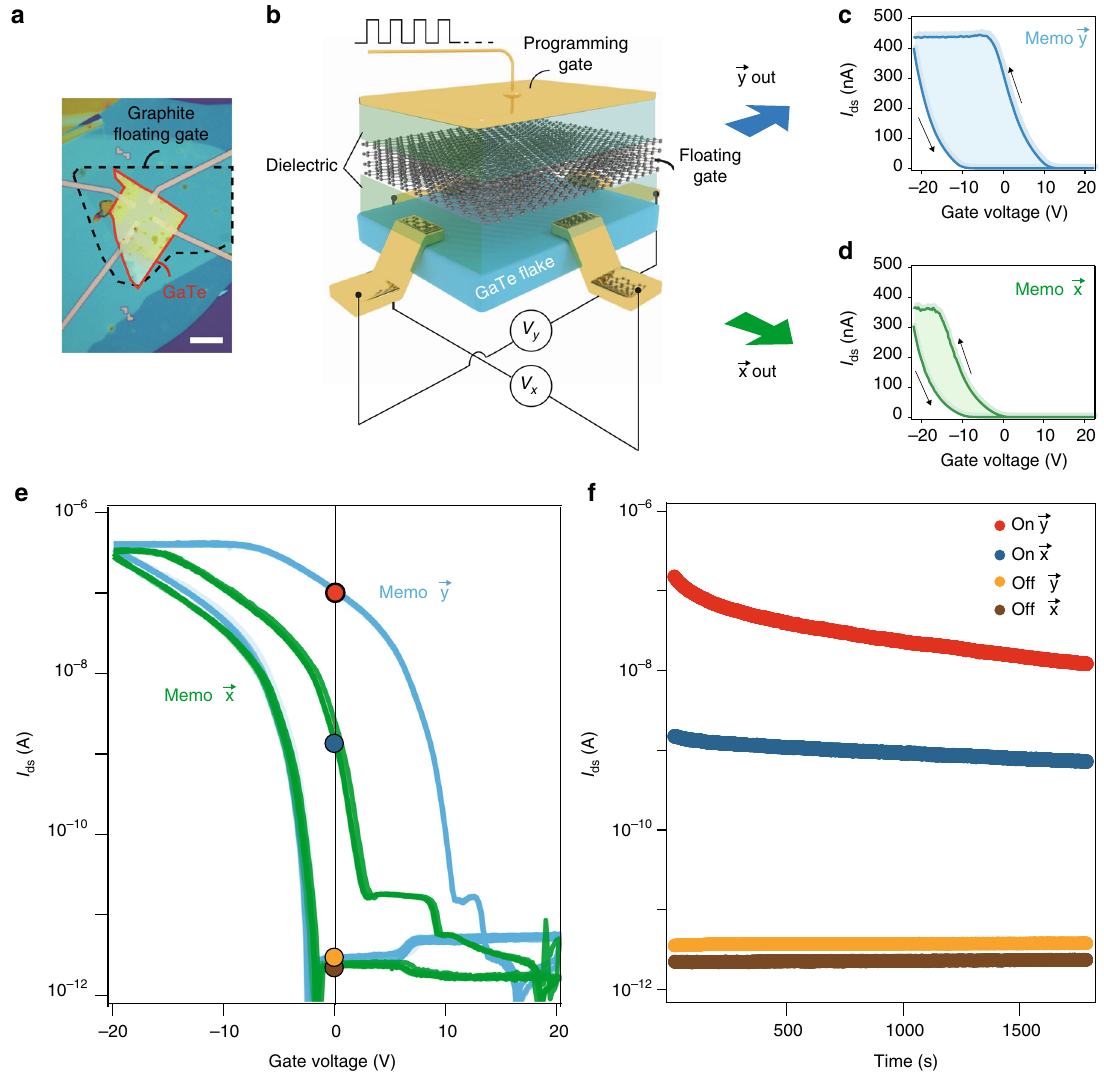
Fig. 3 Anisotropic ultra-thin GaTe fl oating gate memory. a , b Optical image and art view of a typical h-BN/GaTe/h-BN device (Sample S6) with a graphite fl oating gate. Scale bar in a is 10 μ m. c , d Memory curves measured along x and y directions, respectively. e Same data in c and d , plotted in log scales, with 10 repeated measurements (indicated by changing the gradient of the green and blue colors). f Retention time of memory at V g = 0 V, along y and x directions, with on and off positions indicated by the colored circles in e . V = 2 V was used in the above ds